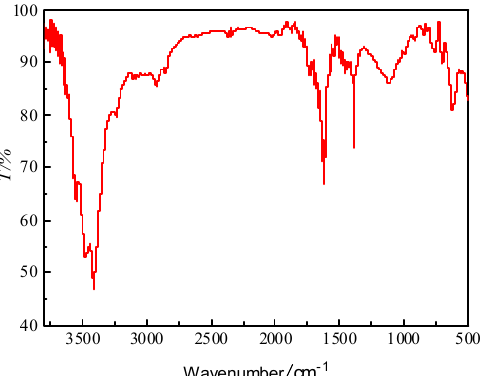
Figure 1. The Fourier transform infrared spectroscopy (FT-IR) spectrum of TEYA.